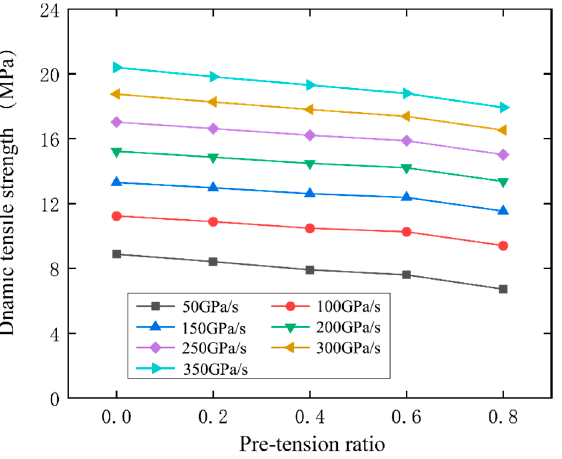
Figure 7. Dynamic tensile strength versus pre-tension ratio curve of naturally saturated FBD speci- mens under different loading rates.